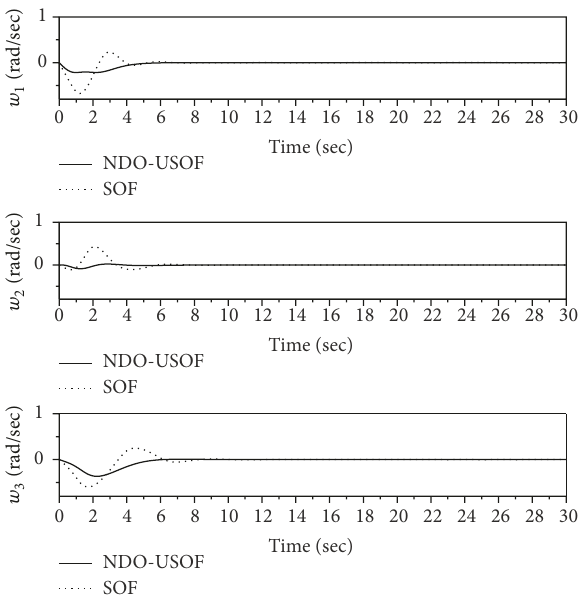
Figure 5: Angular velocity with disturbances.